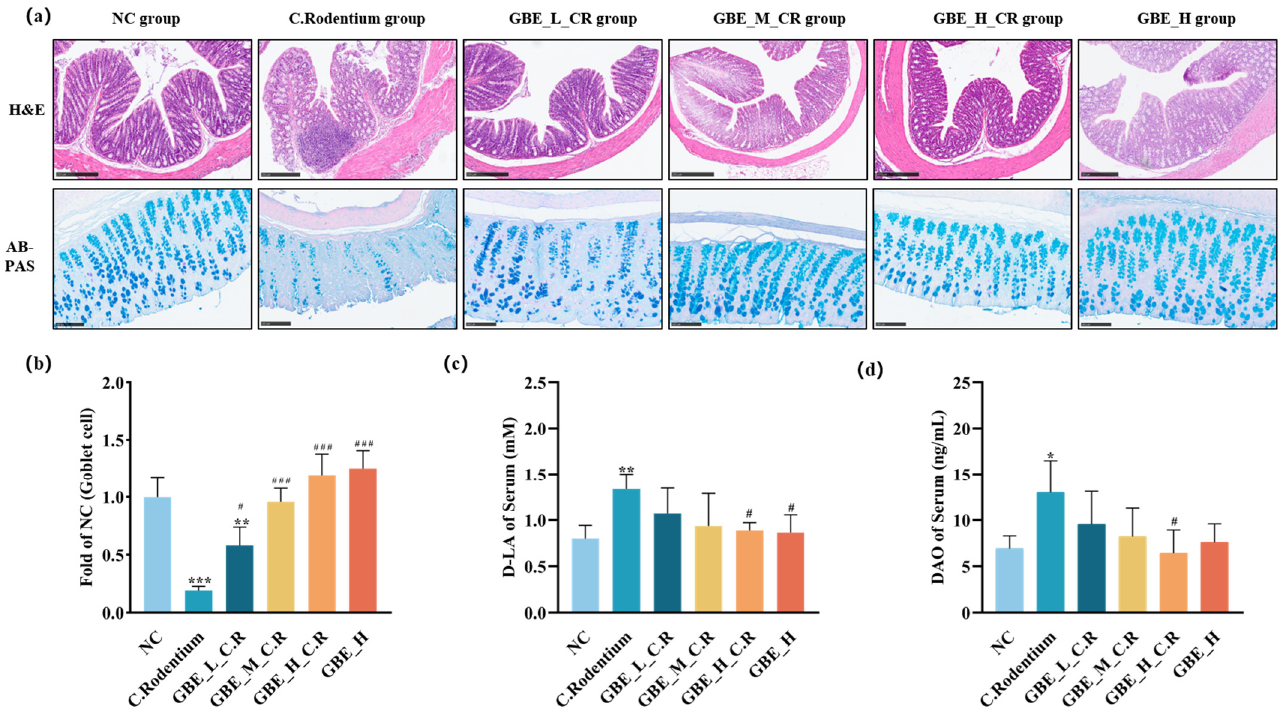
Figure 3. GBE improved the colonic lesions in mice. ( a ) Typical images showing H&E staining on colonic sections (scale bar = 250 µm). Typical images showing AB-PAS staining on colonic sections (scale bar = 100 µm). ( b ) Goblet cell positive density. ( c ) Serum D-LA contents. ( d ) Serum DAO contents. *** p < 0.001, ** p < 0.01, and * p < 0.05 vs. NC group; ### p < 0.001 and # p < 0.05 vs. C. Rodentium group.